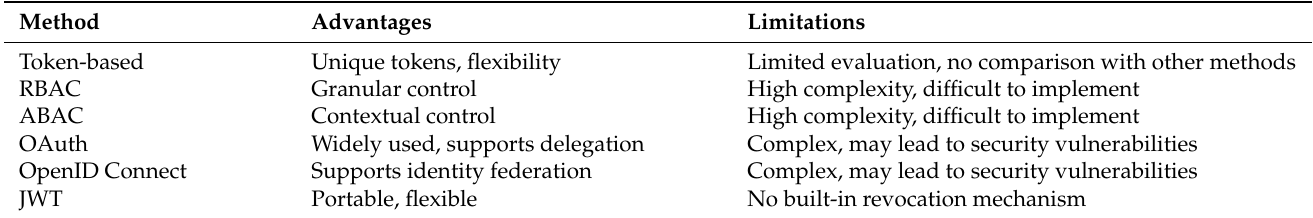
Table 1. Comparison of the access control